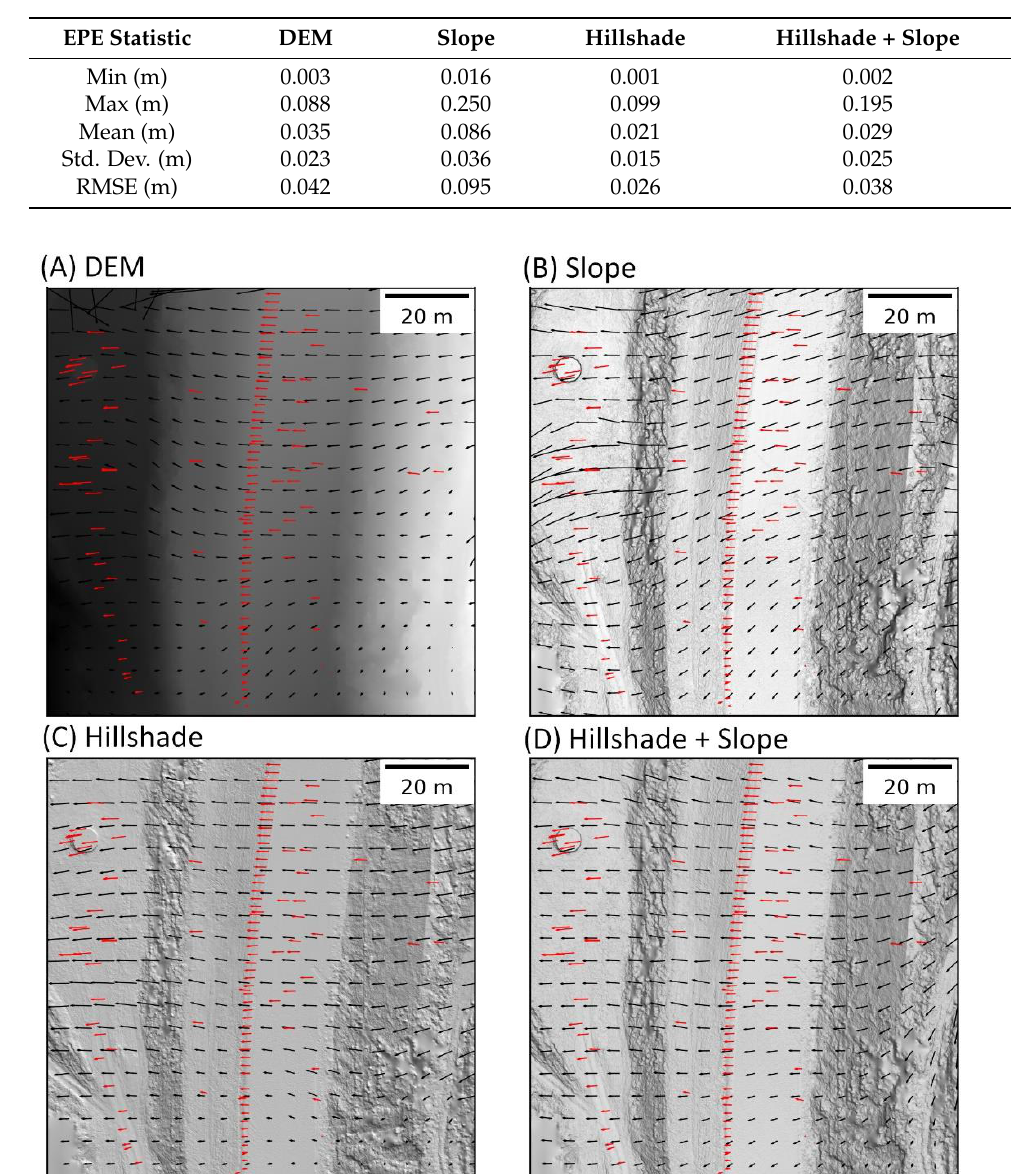
Table 3. 2D Accuracy of the proposed method using several representations of the DEM to compute landslide displacement reported as EPE (end-point error) in meters compared to ground truth points.